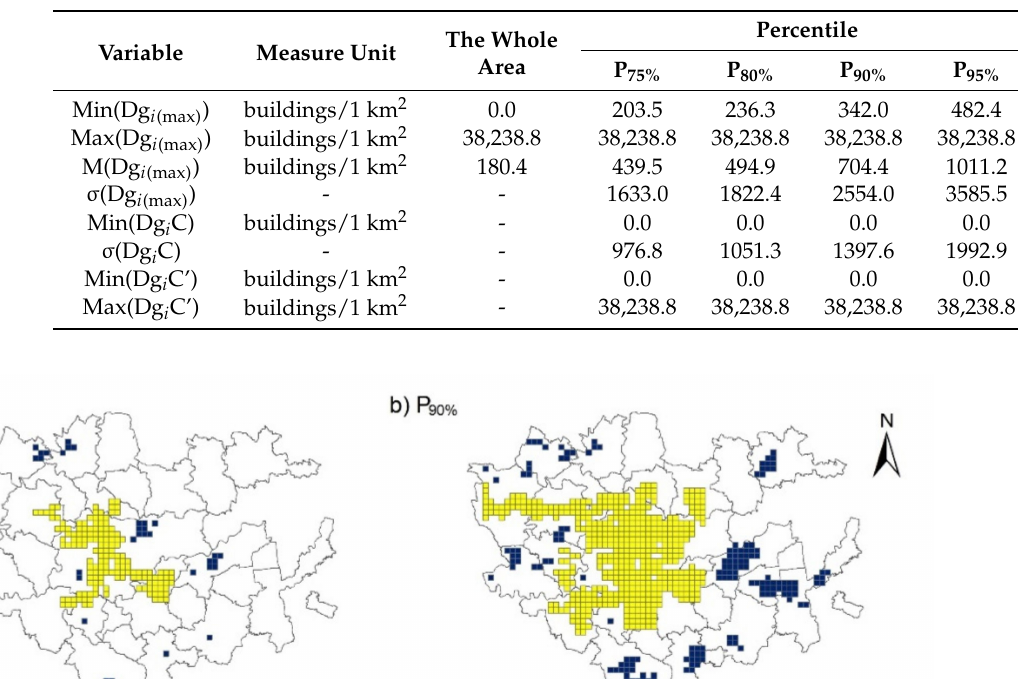
Table 1. Statistics on the building density of squares, including extreme values.